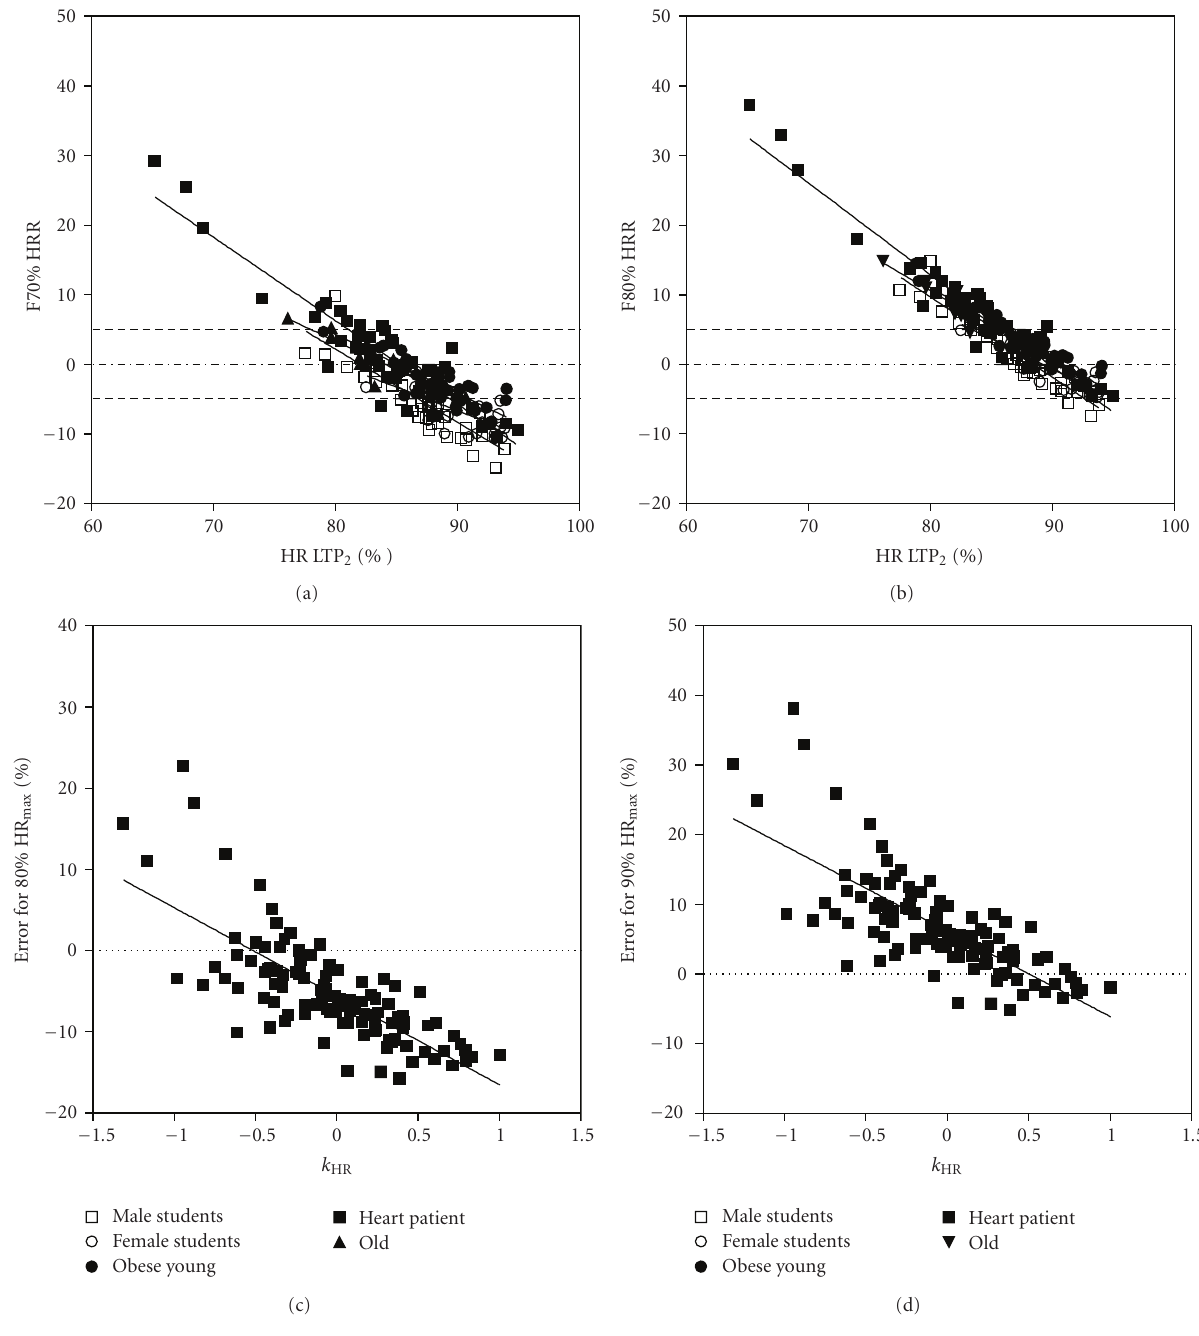
Figure 3: Error of estimate for percent heart rate reserve (HRR) compared to %HR at the second lactate turn point (LTP 2 ) as well as the error of estimate for percent HR max related to the deflection of the heart rate performance curve (kHR) [29, 30] in healthy young male and female sports students, young obese subjects, older healthy subjects, and patients after myocardial infarction [31].